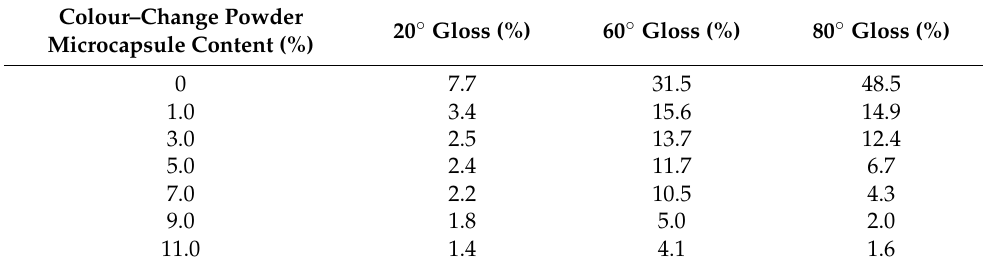
Table 6. Analysis table of colour difference value